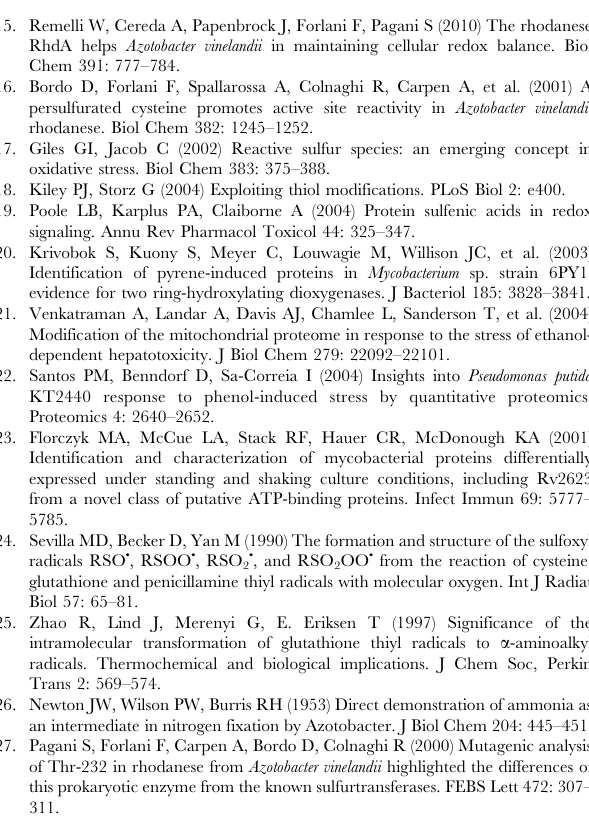
Table S1 Effect of RhdA lack on levels of cysteine and L - glutamate, and on glutathione disulfide reductase (GR) activity in A. vinelandii . Significant differences between the strains at the level of P , 0.05 and P , 0.01 (Student’s t test) are indicated as * and **, respectively. All values represent means 6 standard deviation (SD) for three independent determinations. a Taken from Cartini et al.